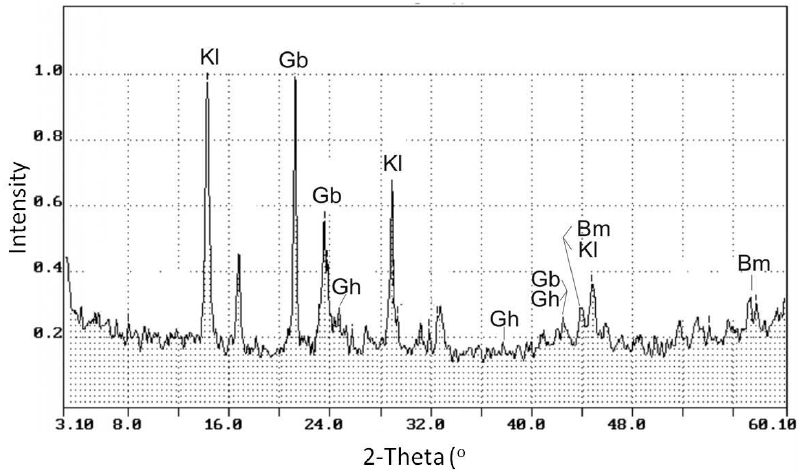
Figure 4. XPD parrent of bauxite: Kl — kaolinite, Gb — gibbsite, Bm — boehmite, and Gh — goethite.